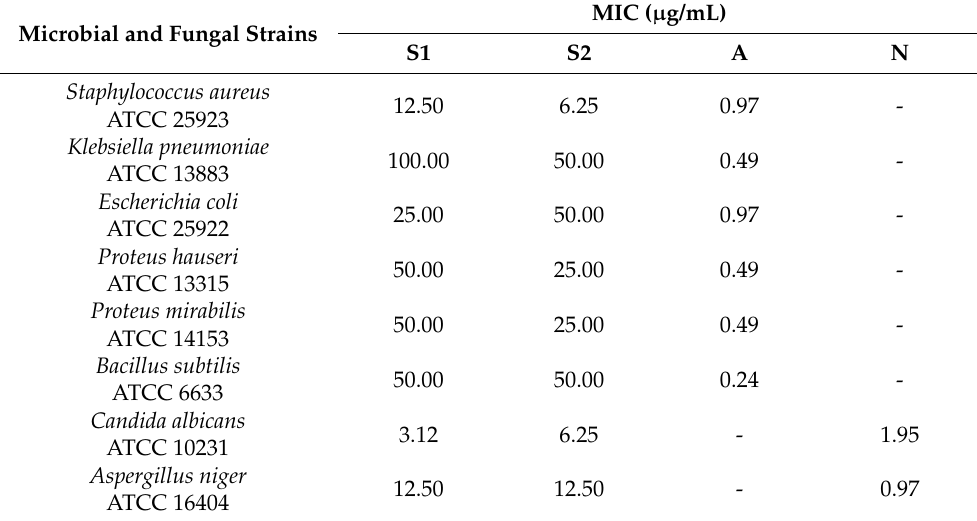
Table 3. Antimicrobial activity of Sideritis sipylea essential oil extracted from wild-growing Greek material (S1: mid-summer collection, Samos Island; S2: early summer collection, Lesvos Island) against six microbial and two fungal strains compared to reference antibiotics for bacteria (A: Amracin) and fungi (N: